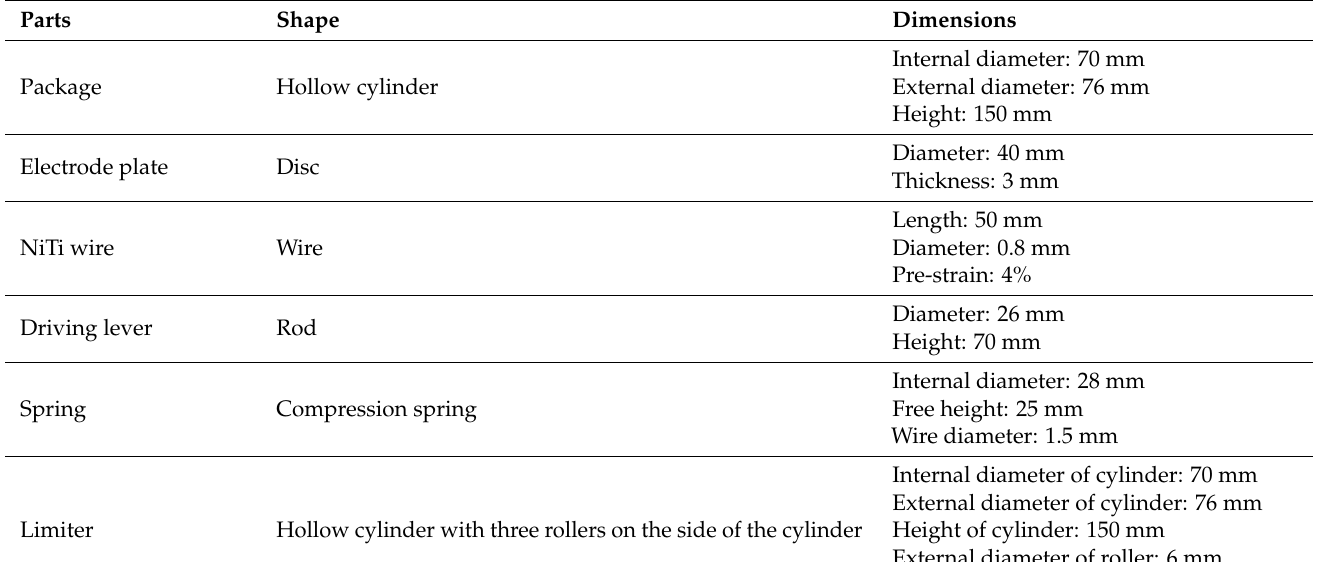
Table 5. Design of the proposed actuator prototype.